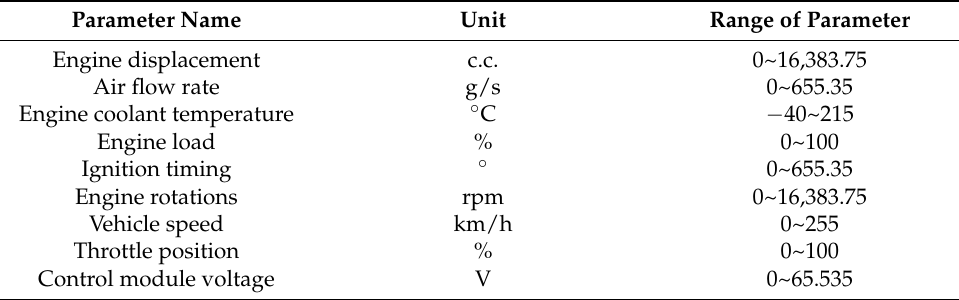
Table 2. Input parameters of the neural network.